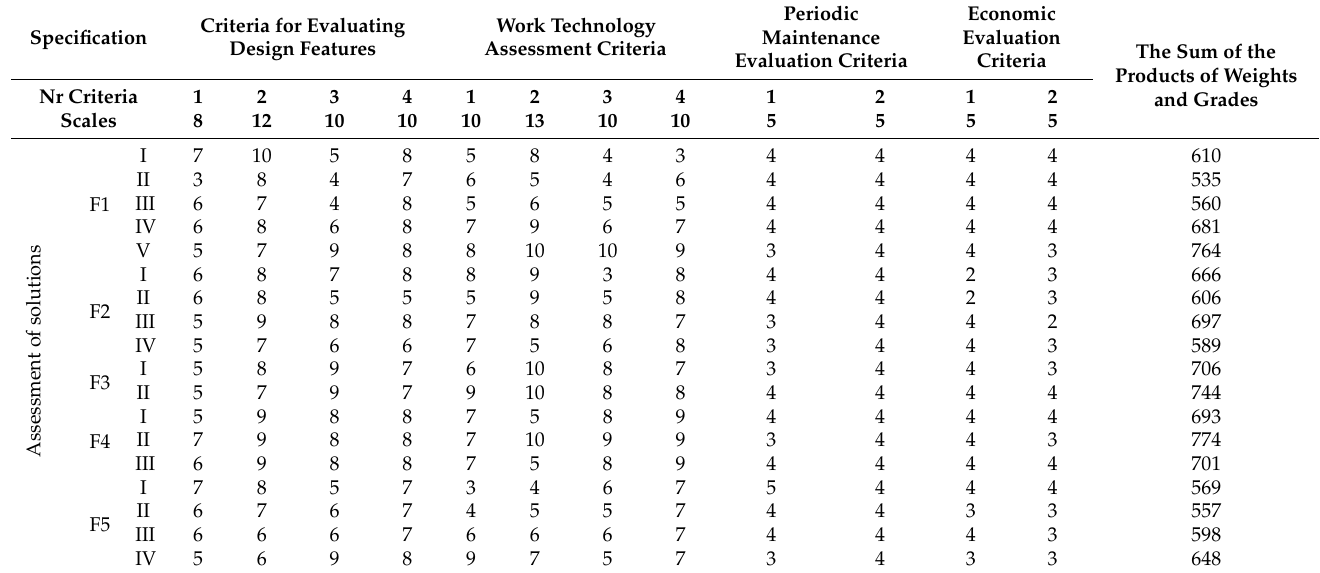
Table 3. Assessment of individual design solutions of variants of working teams, in relation to the adopted evaluation criteria, strawberry fruit-harvesting